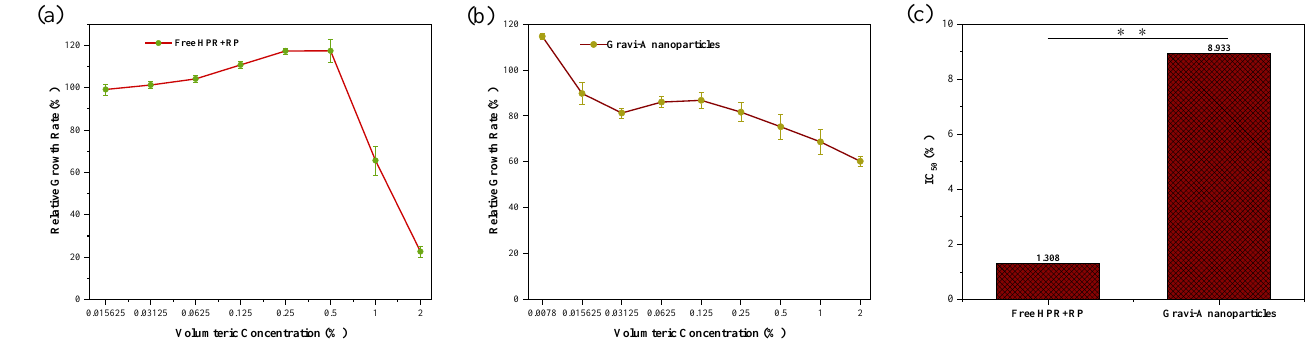
Figure 3. Relative growth rates (RGR) of ( a ) free HPR + RP and ( b ) supramolecular Gravi-A nanoparticles. ( c ) Human dermal fibroblast cells detected by MTT assay (** p < 0.01).